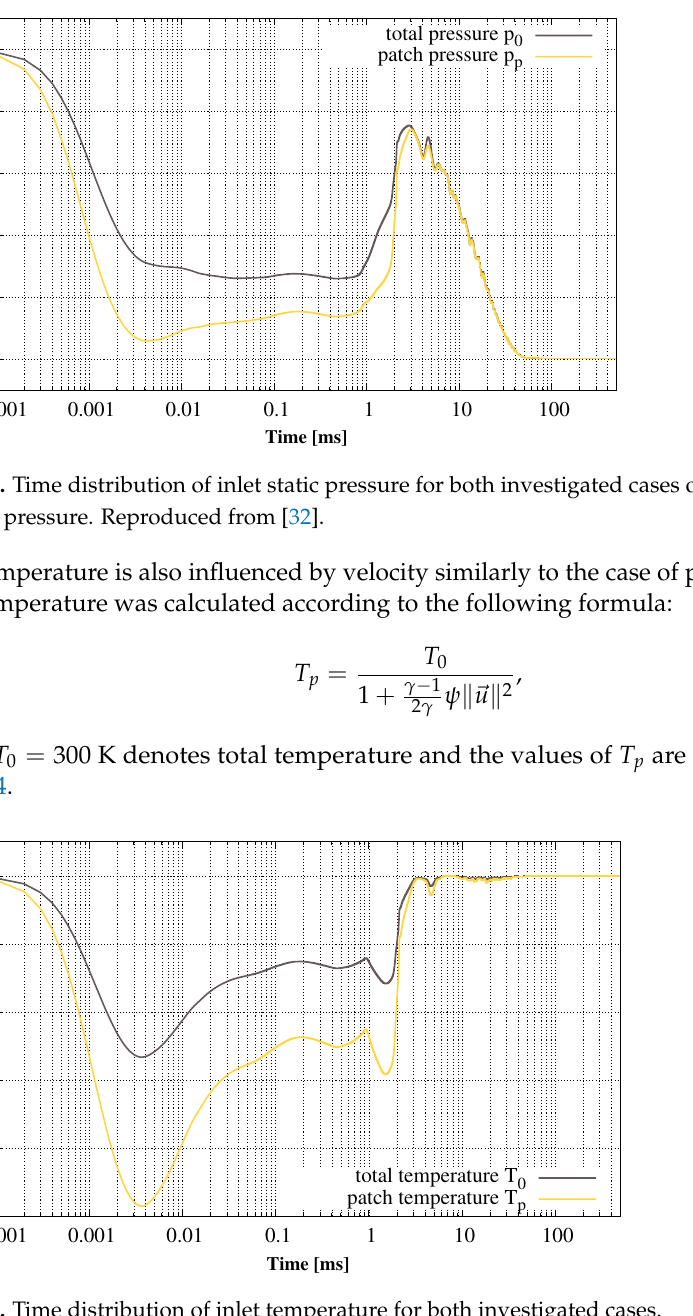
Figure 4. Time distribution of inlet temperature for both investigated